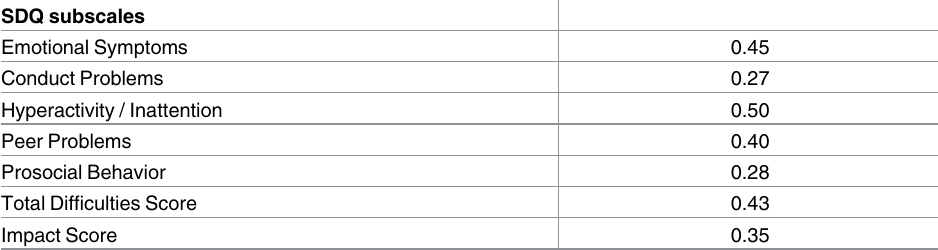
Table 3. Inter-rater agreement of the SDQ-T with the SDQ-P.